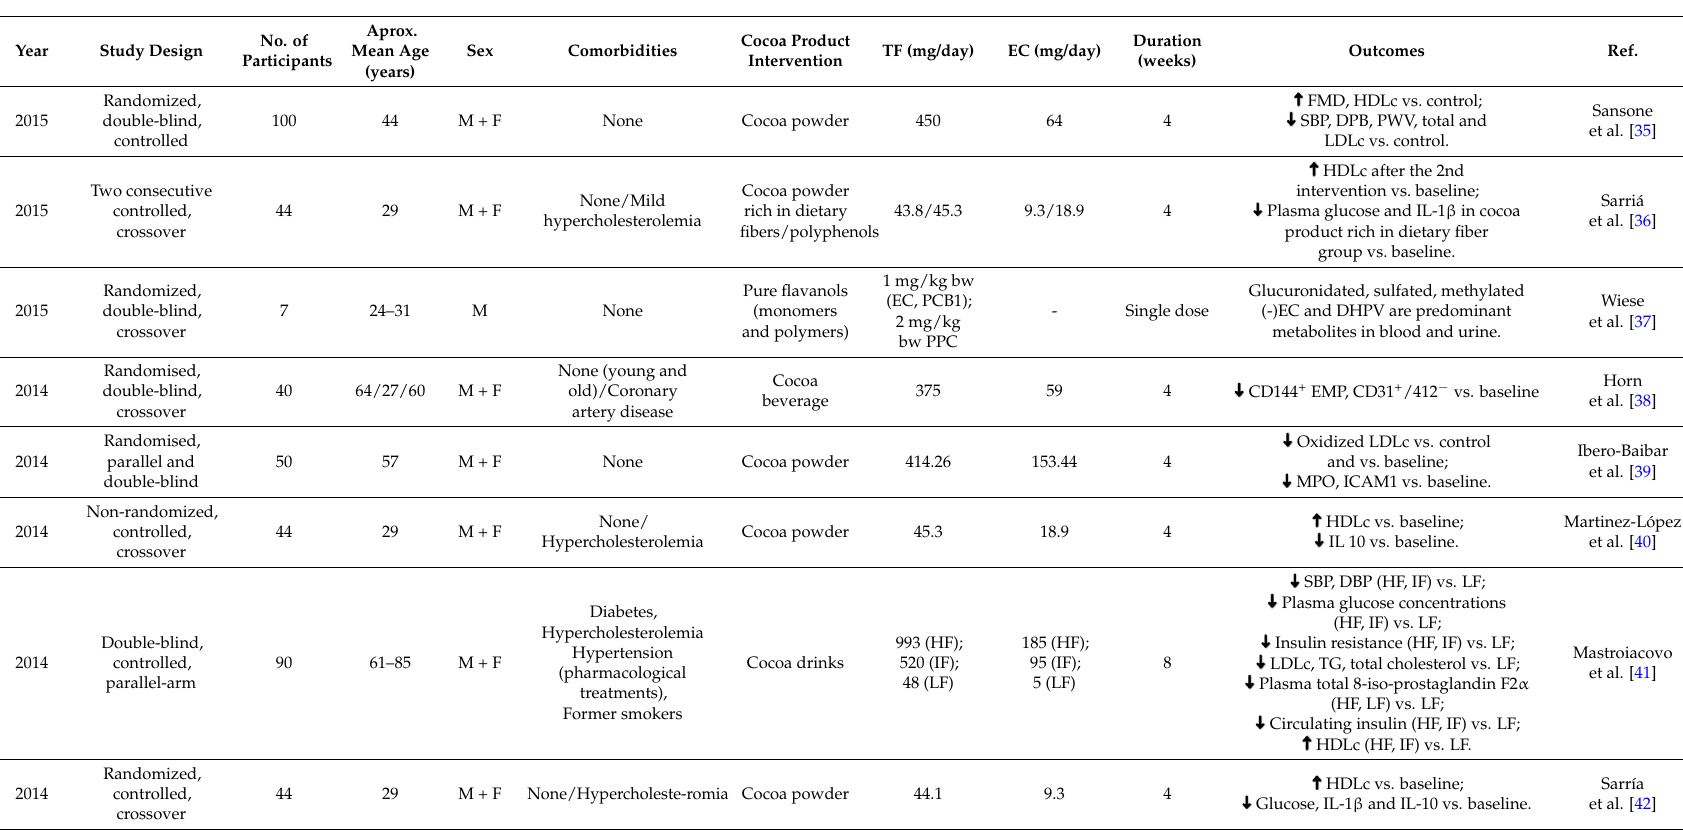
Table 1. Cont. Table 1. Outcomes of recent (2014–2016) clinical trials of cocoa products.